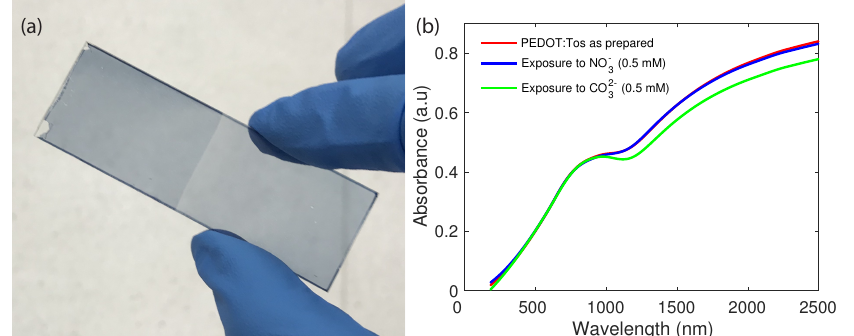
Figure 2. ( a ) The change in PEDOT color from light blue to dark blue in the visible due to oxidation by NO − (1 mM) after 24 h exposure, ( b ) absorbance spectra of PEDOT before and after exposure to 3 NO − and CO 2 − for 2 3 3